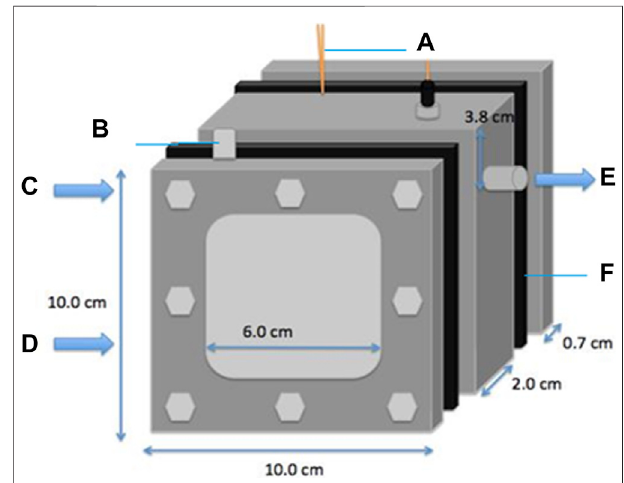
FIGURE 2 | Air cathode single chamr fuel cell reactor having (A) Lignin based carbon anode (B) Catalyst on carbon-PTFE cathode (C) hole for capilaryreferenceelectrode (D) holeforin fl owofanolyte (E) holeforout fl owof anolyte (F) Rubber gaskets.